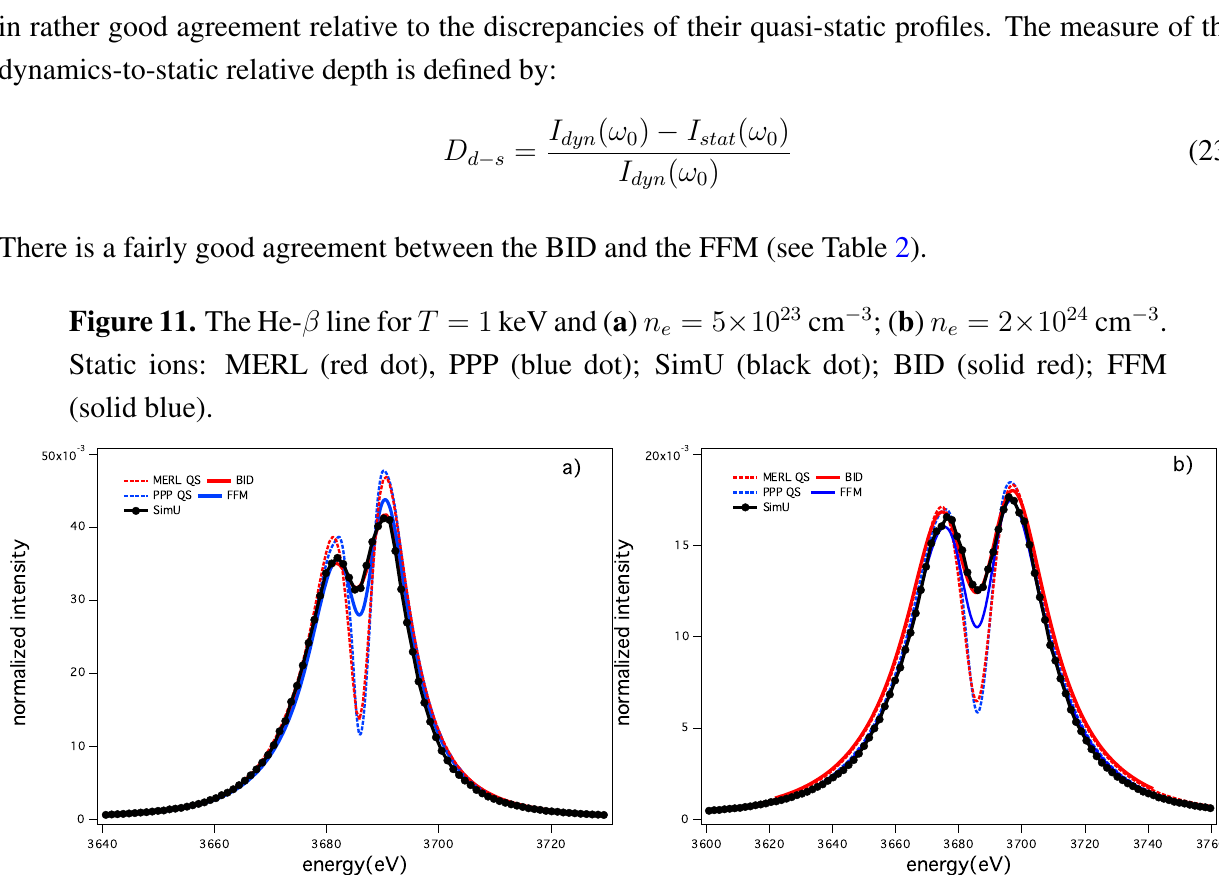
= 5 (cid:2) 10 23 cm (cid:0) 3 : e